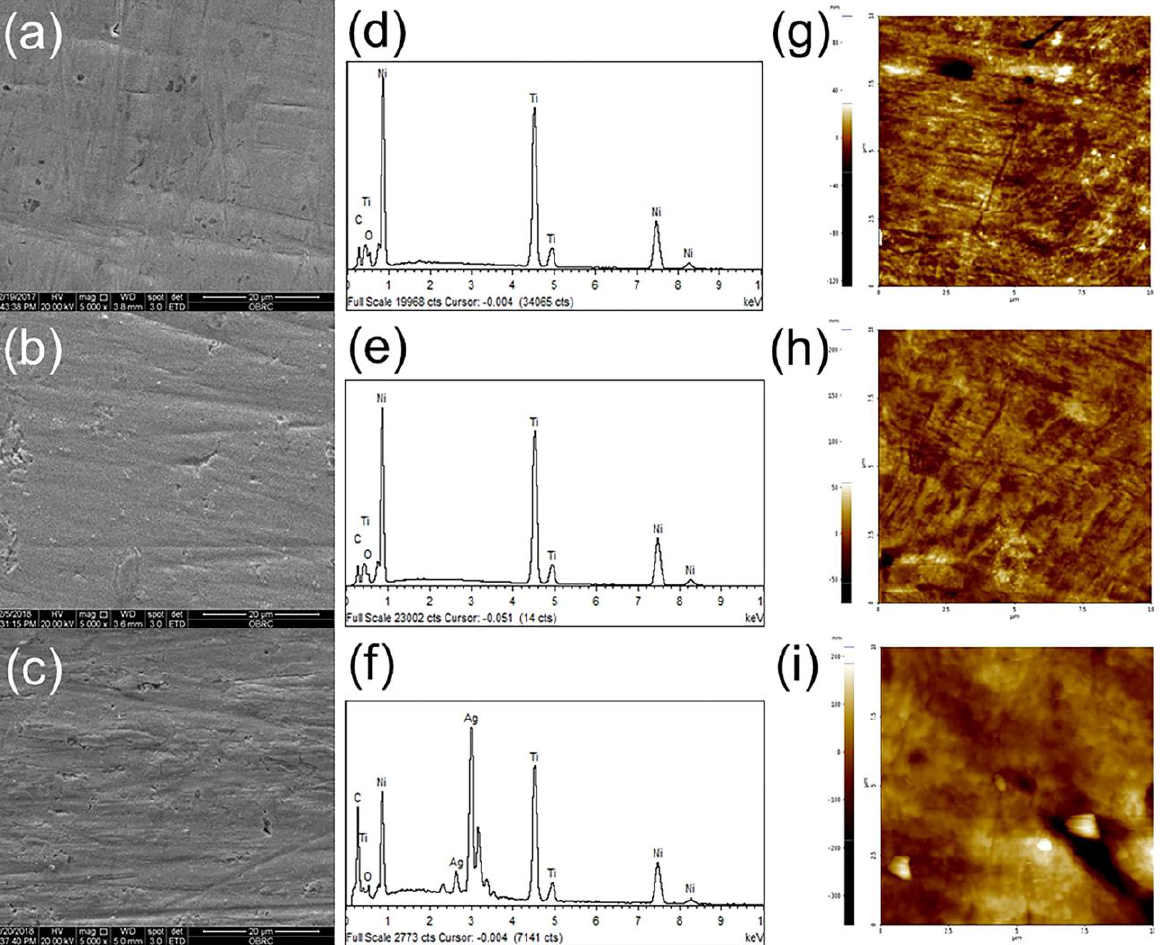
Figure 9. ( a – c ) Scanning electron microscope (SEM) images, ( d – f ) energy-dispersive spectroscopy (EDS) analysis, and ( g – i ) atomic force microscope (AFM) images of the bare NiTi, GO-coated NiTi, and GO/Ag-coated NiTi alloy, respectively. Adapted with permission from [181].